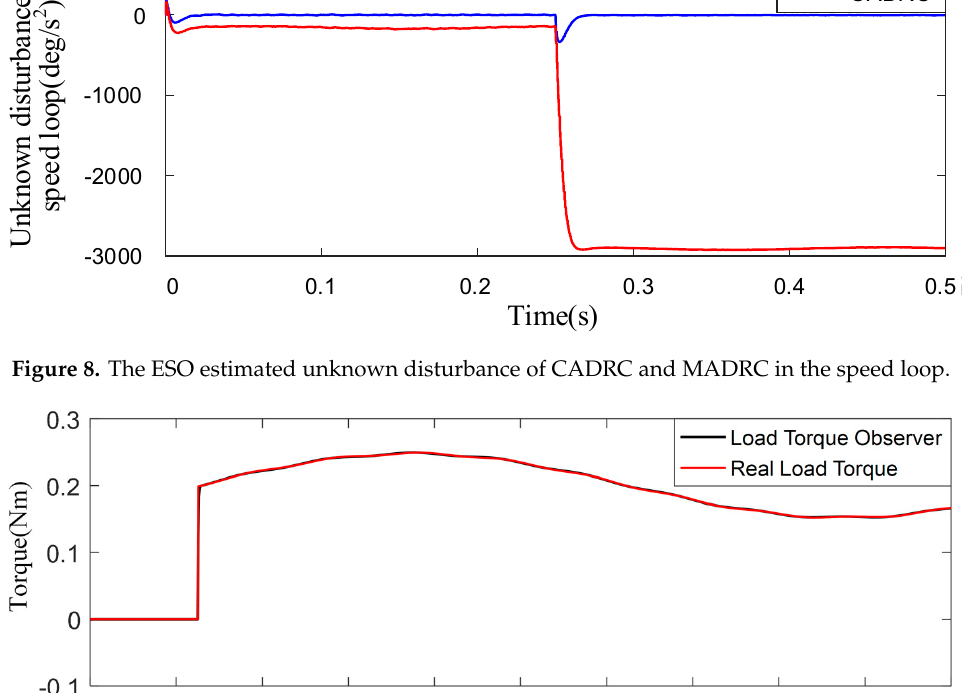
Figure 9. The load torque variation and load torque observer output.